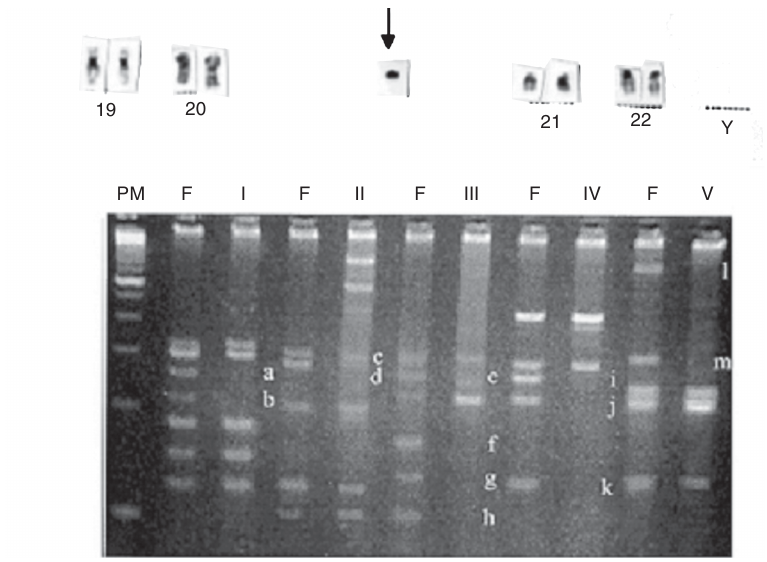
Figure 1. Top : Male infertility studies by classical cytogenetics and multiplex PCR for microdeletions of AZF gene detection. Partial karyotype of patient with 46,X,del(Y). The arrow indicates the Y deleted chromosome. Bottom : Multiplex PCR revealed deletion of 13 sequence-tagged sites indicated by letters a to m . PM = ladder; F = fertile man; I to V = mix I to V; a = sY117; b = sY102; c = sY143; d = sY157; e = sY105; f = Y6HPc54pr; g = sY153; h = sY97; i = sY127; j = sY109; k = sY149; l = Y6BaH34pr; m